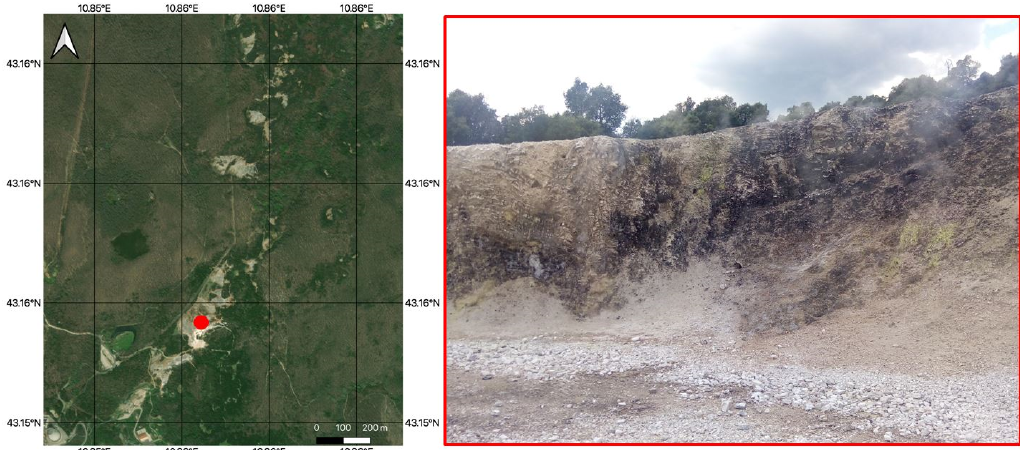
Figure 2. Test site: left, Parco delle Biancane (Monterotondo Marittimo, Grosseto, Italy); right, presence of fumaroles in the test site (in red the position on the map of the collected picture).